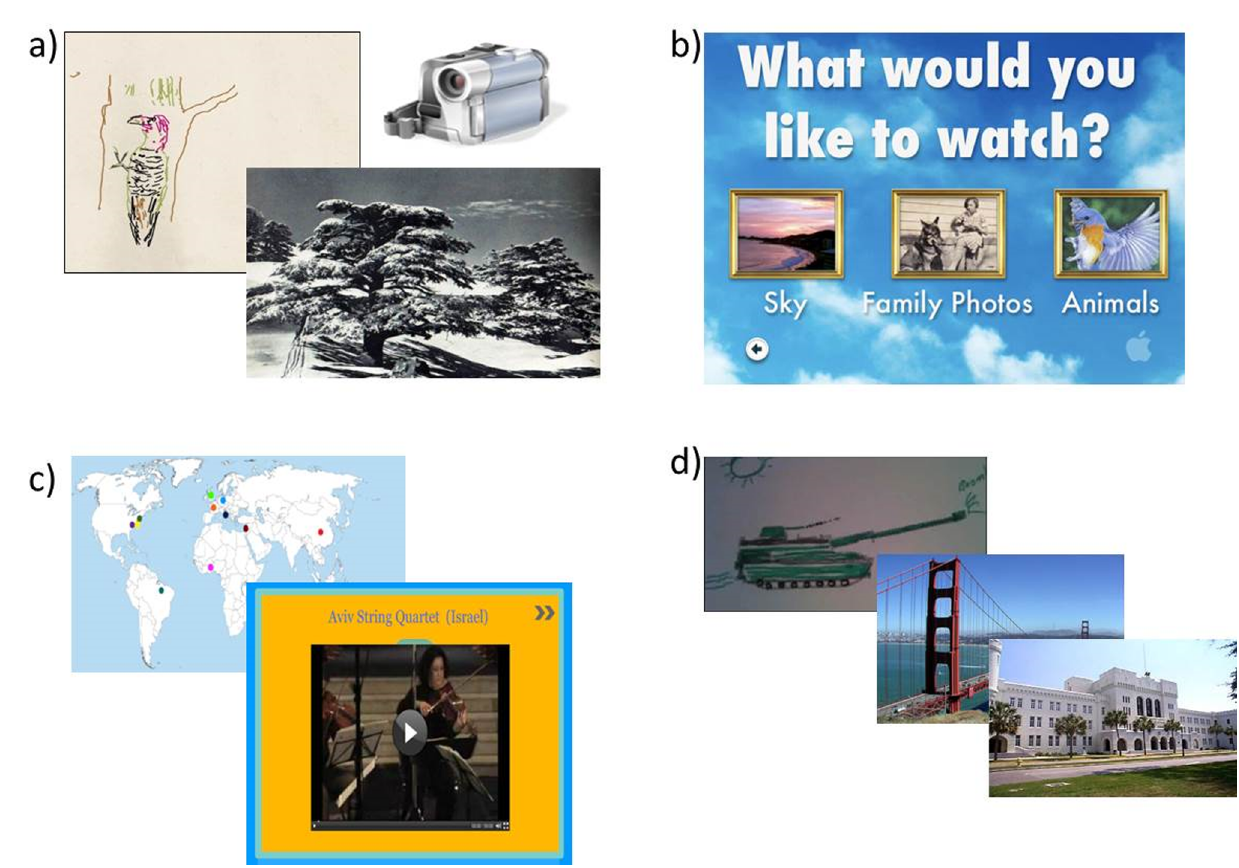
Figure 1. Sample project content: a) Video scrapbook narrated by community partners, consisting of family photographs, drawings made on an iPad, and photographs chronicling family history and important achievements; b) “virtual window” of favorite things, displayed on large screen with headphones to address hearing and vision impairments; c) interactive map that showcased music from around the world, linked to video performances on YouTube; and d) digital scrapbook highlighting time in the military, favorite travel destinations, coloring book, sing-along picture books, and army